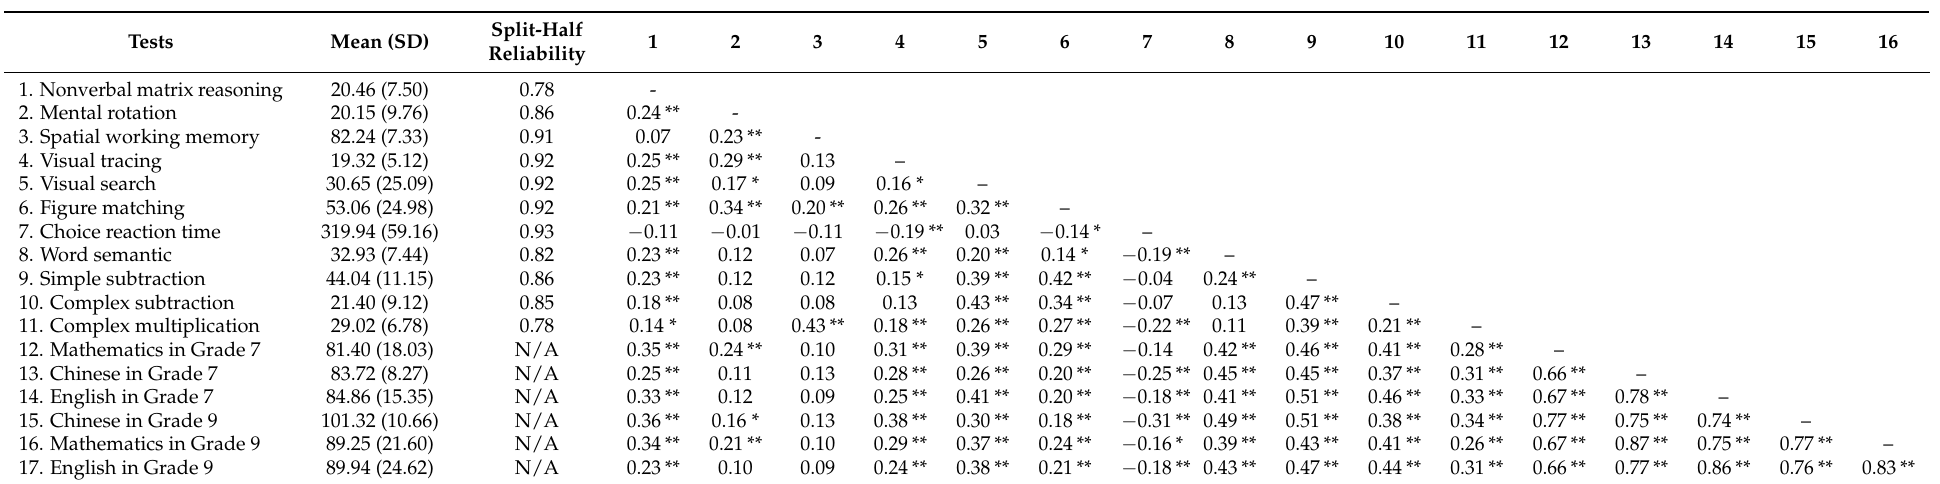
Table 1. Descriptive statistics and correlations of cognitive abilities and academic achievement among all